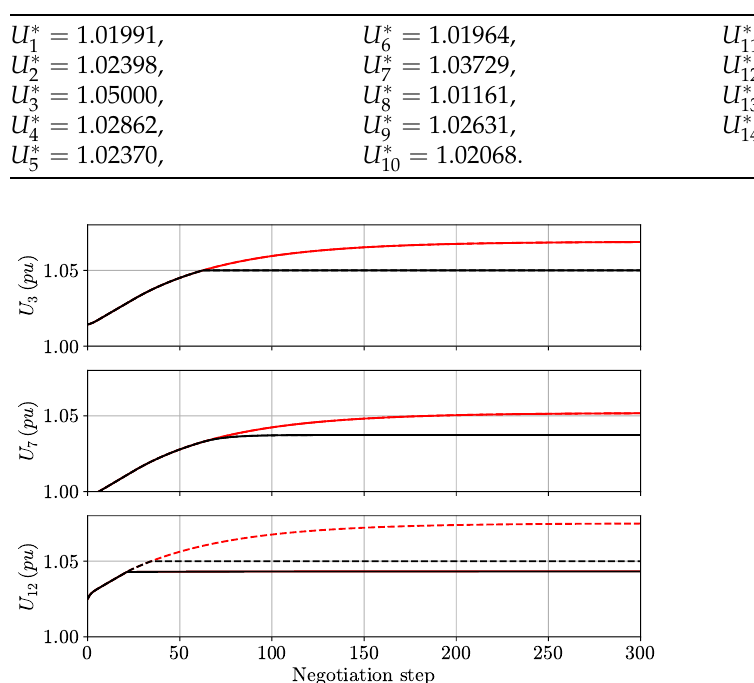
Figure 4. Buses 3, 7, and 12 negotiation and the associated constraints (dashed lines) for: (i) original problem of Example 2 (black ink); (ii) problem stated in Example 2 when Constraint 1 is not taken into account (red ink).